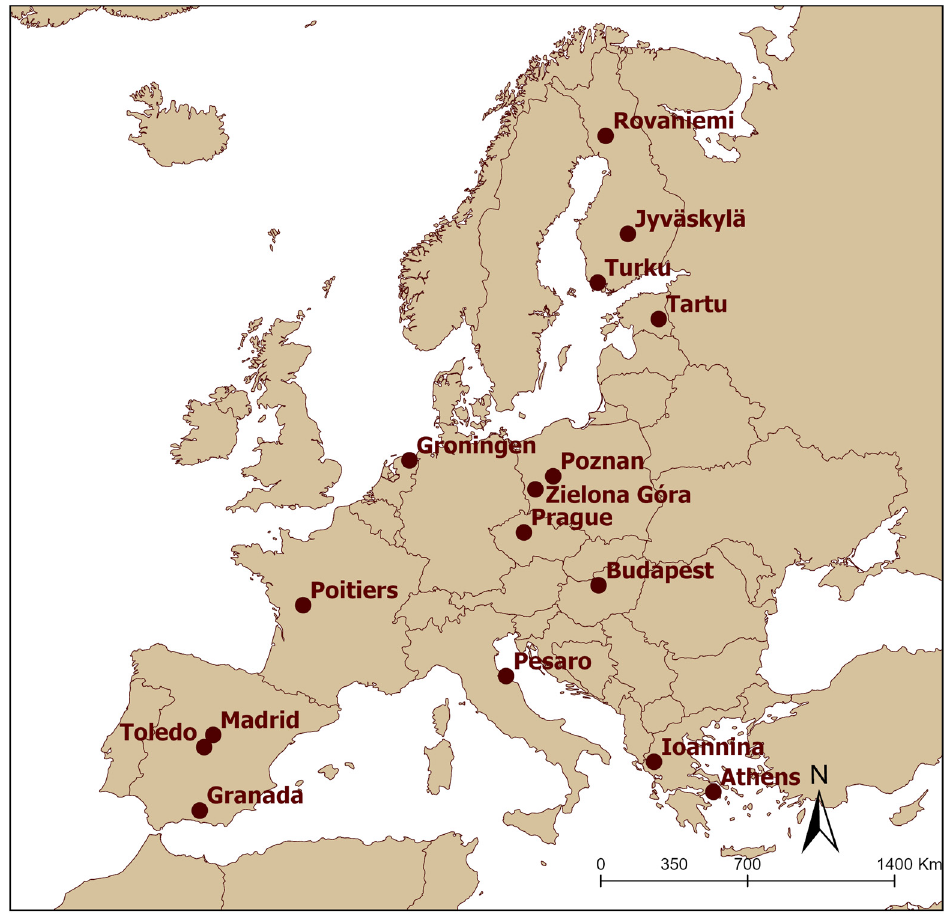
Figure 1. Map of the sixteen European cities surveyed.